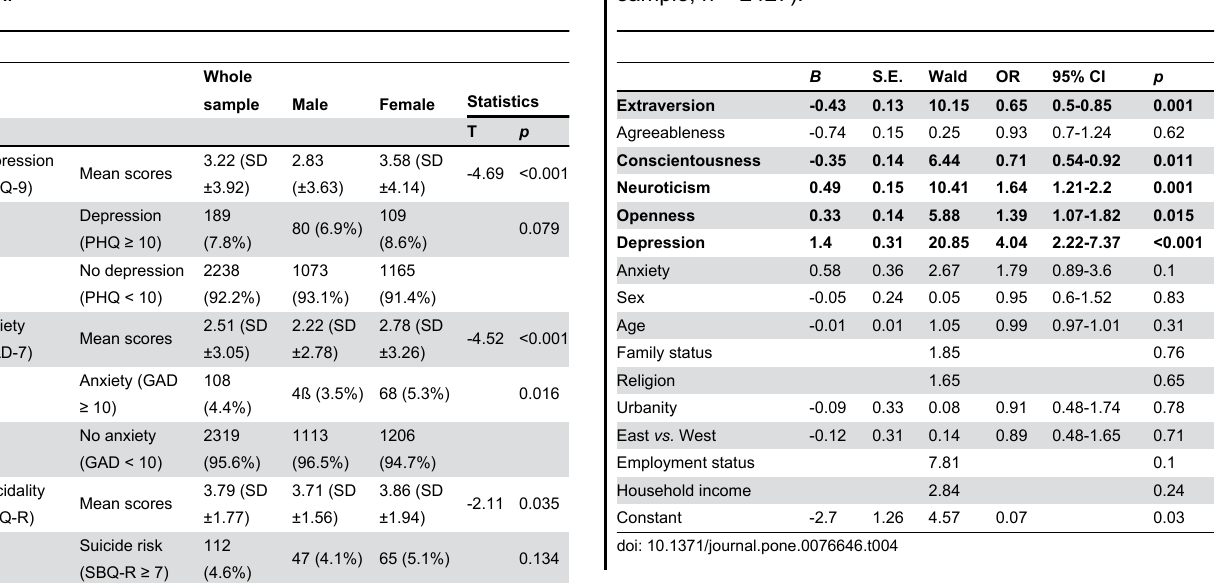
Table 2. Prevalence of depression, anxiety, and suicide risk.